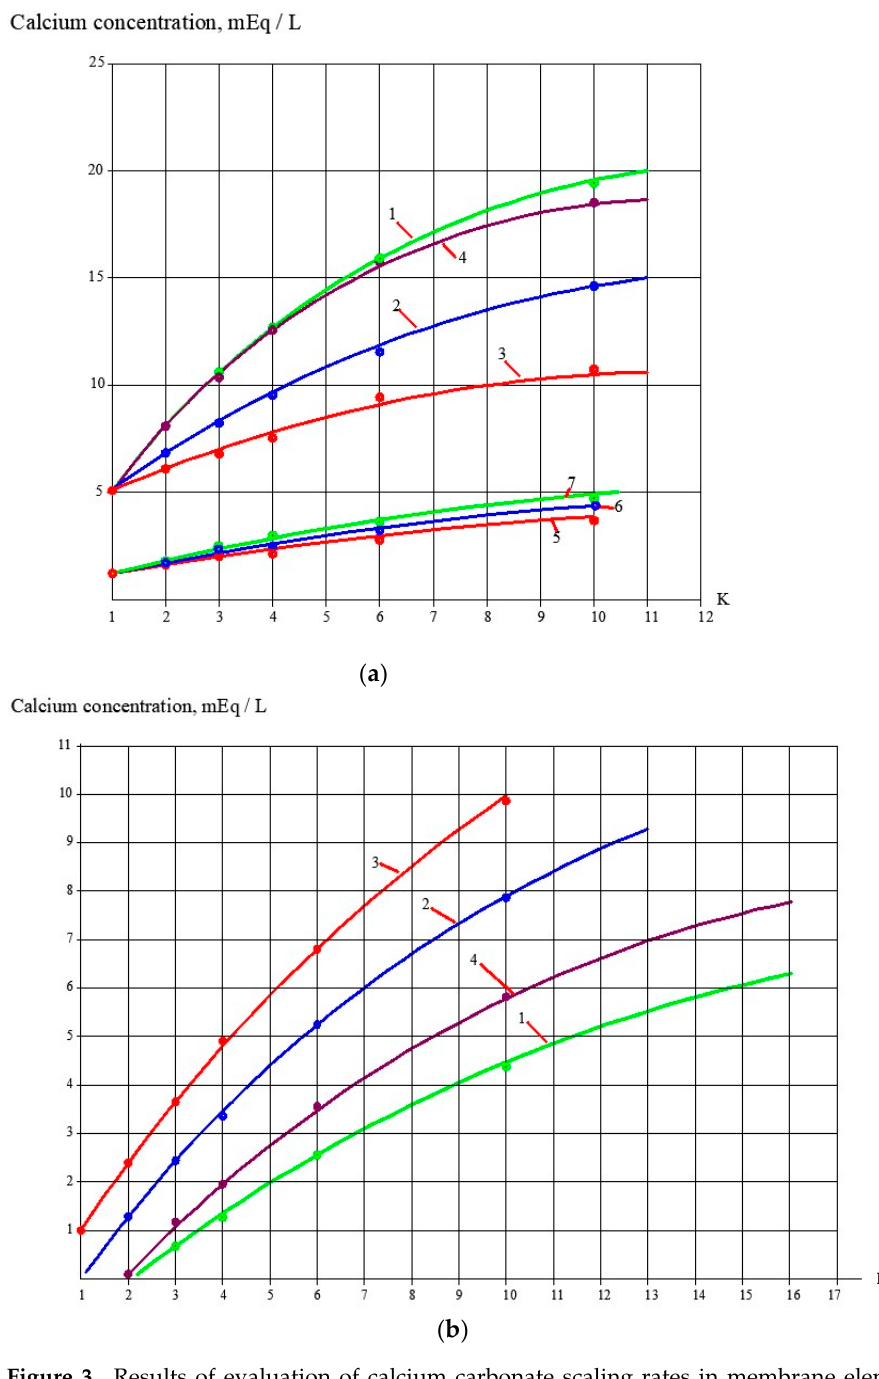
Figure 3. Results of evaluation of calcium carbonate scaling rates in membrane elements with nanofiltration membranes: dependencies of concentration of calcium in concentrate volume on K values ( a ); dependencies of calcium carbonate scaling rates on K values ( b ); 1—Aminat-K, 5 ppm; 2—Jurby-Soft, 5 ppm; 3—without antiscalant addition; 4—Aminat-K, 2 ppm; 5—product flow after addition